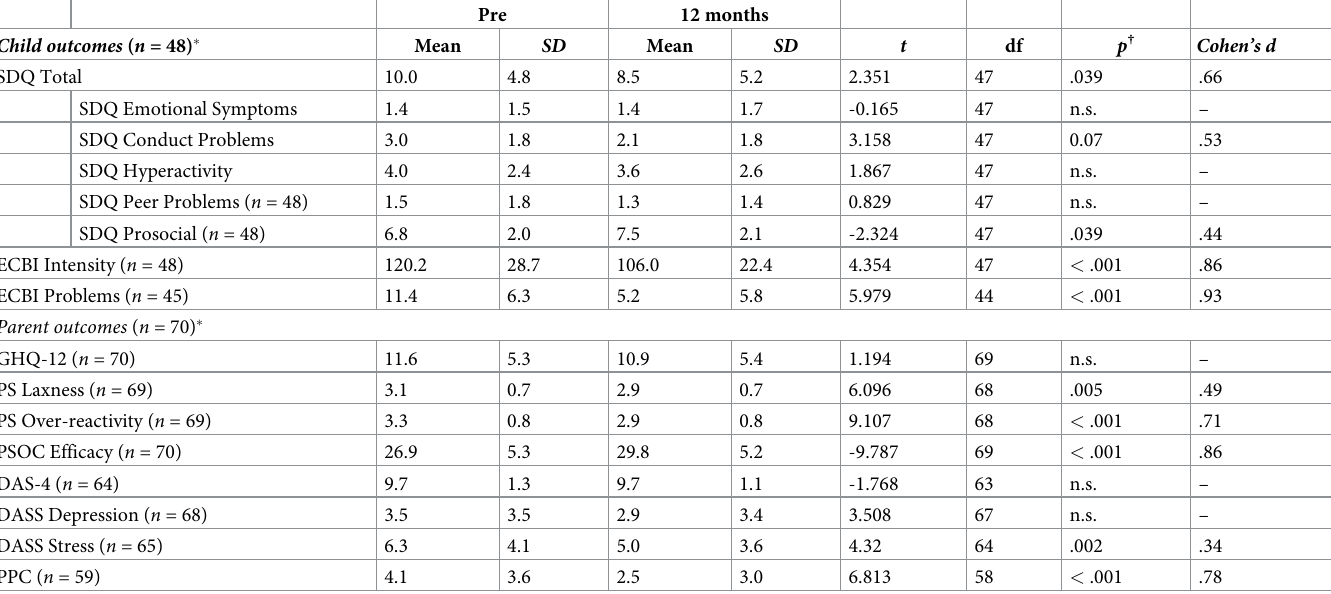
Table 3. T-tests for Triple P group 12 month follow-up